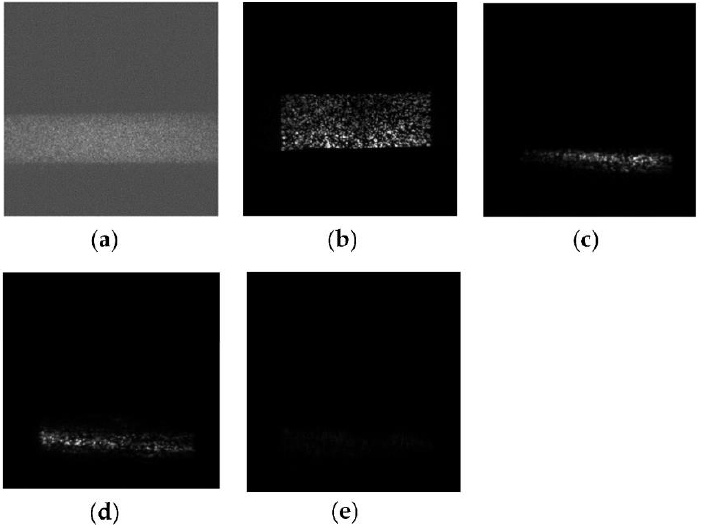
Figure 3. Images taken by the streak camera: ( a ) background image. ( b ) Pattern image. ( c ) Observed image (photoresist: water = 1:3 volume ratio). ( d ) Observed image (the volume ratio of photoresist: water = 1:1 volume ratio). ( e ) Observed image (without water addition).